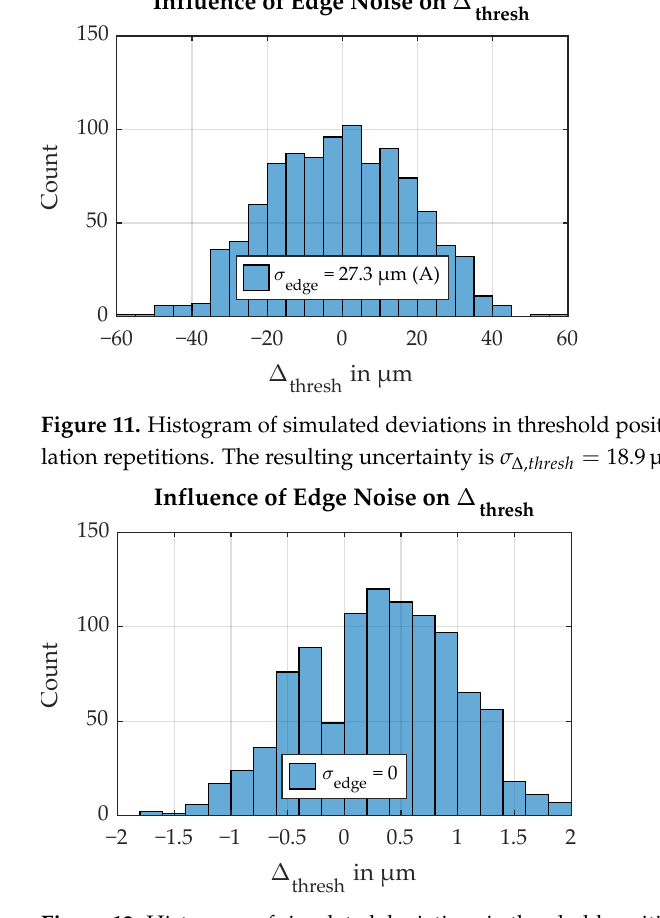
Figure 12. Histogram of simulated deviations in threshold position ∆ thresh , simulation noise, 1000 sim- ulation repetitions. The simulation noise comes from the discretization of the ray tracing. The resulting uncertainty is σ ∆ , thresh =